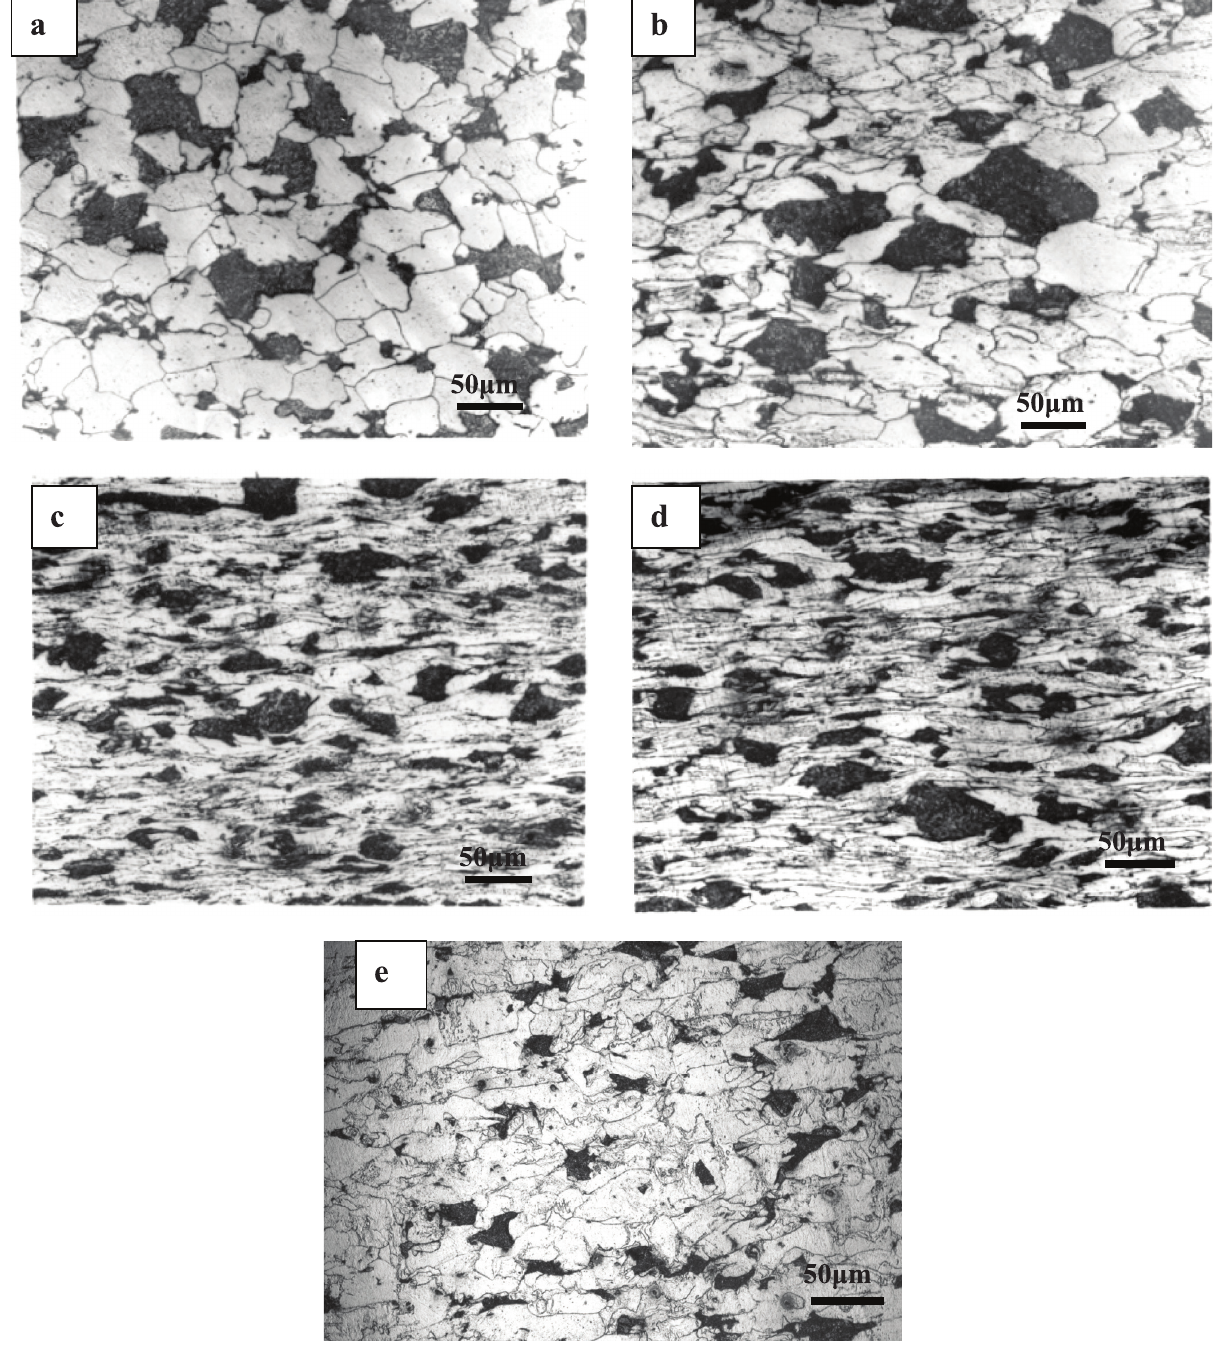
Fig. 1: Microstructure of (a) undeformed, (b) 10.2% deformed, (c) 24.4% deformed, (d) 50.4% deformed, and (e) 70.7% deformed